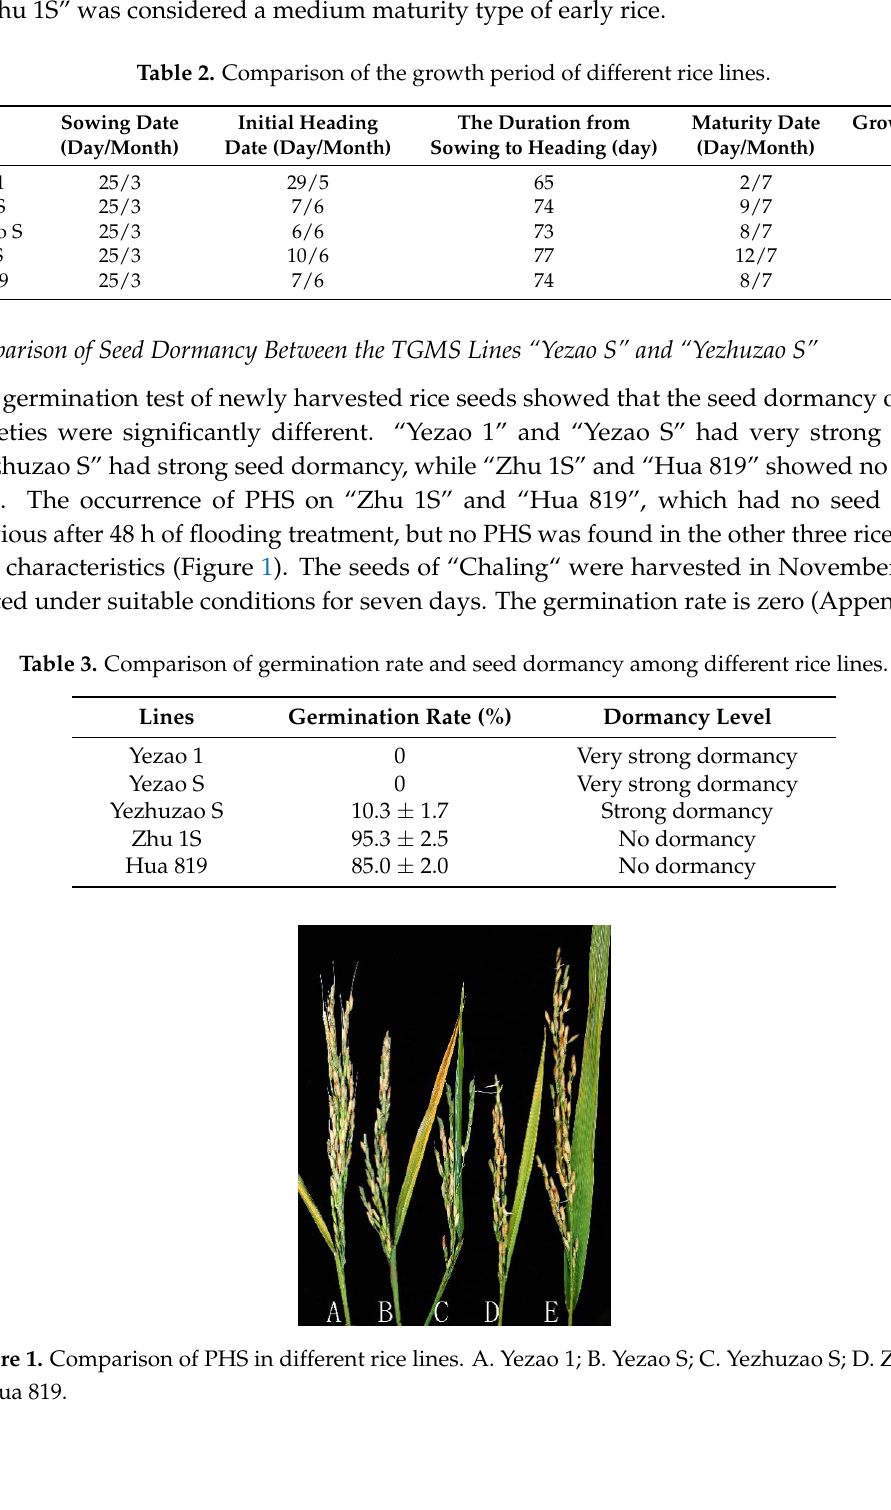
Table 2. Comparison of the growth period of different rice lines.